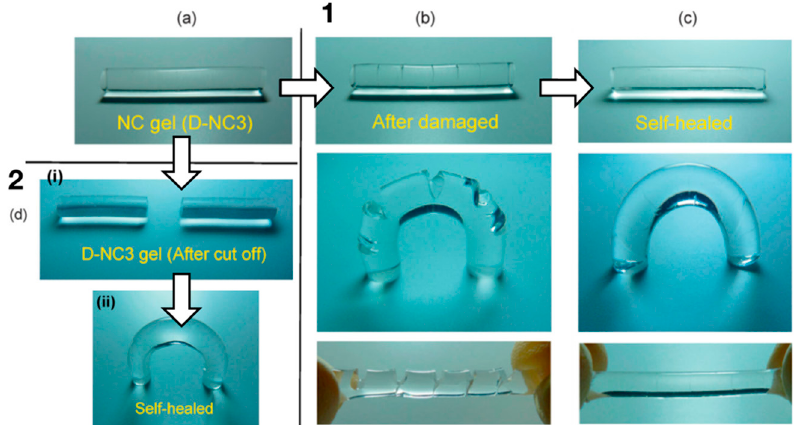
Figure 7. Self-healing nanocomposite hydrogel composed of PDMAm and hectorite clay NPs (D-NC3). The nanocomposite hydrogels were (1) damaged or (2) cut off using a knife and then healed by keeping the cut surfaces in contact at 37 °C for varying times, ranging from 48 to 100 h. Reprinted with permission from Haraguchi, K.; Uyama, K.; Tanimoto, H. Self-healing in Nanocomposite